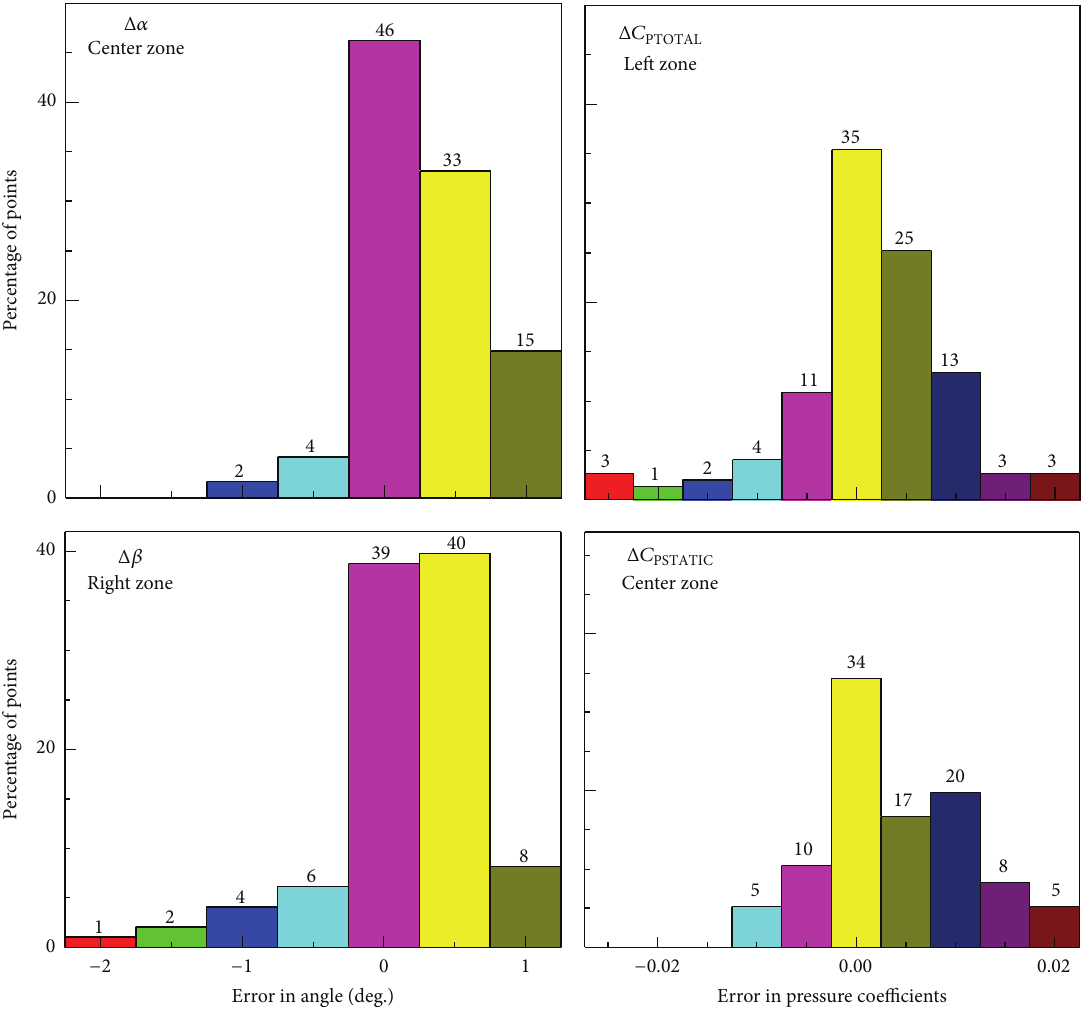
Figure 10: Histograms of interpolation errors of the four-hole probe in different zones.